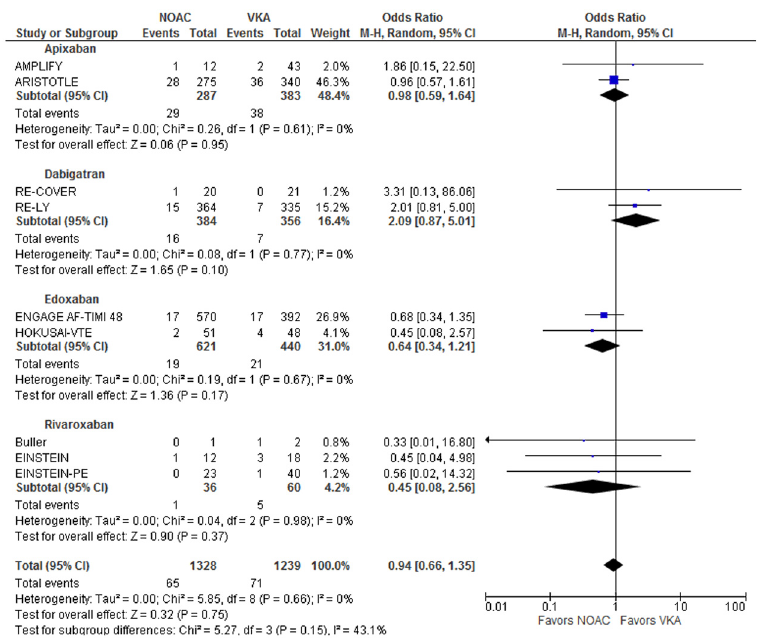
Fig 5. Relative odds of fatal bleeding given patient with major extracranial bleeding event. Odds ratios and 95% confidence intervals are given for the relative odds that major extracranial bleeding events will lead to fatal bleeding